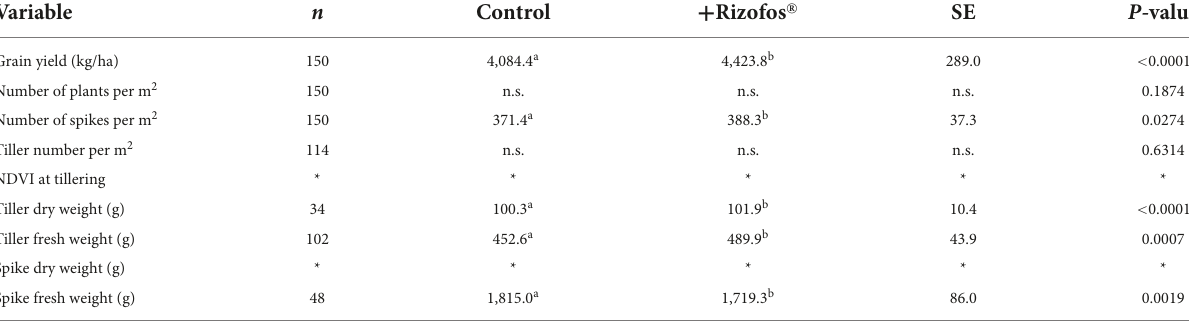
TABLE 2 Agronomic efficiency of Pseudomonas sp. strain 1008. Variable n